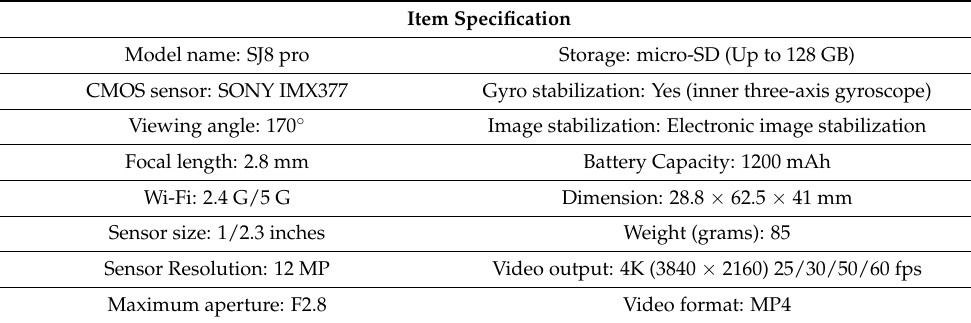
Table 1. Action camera